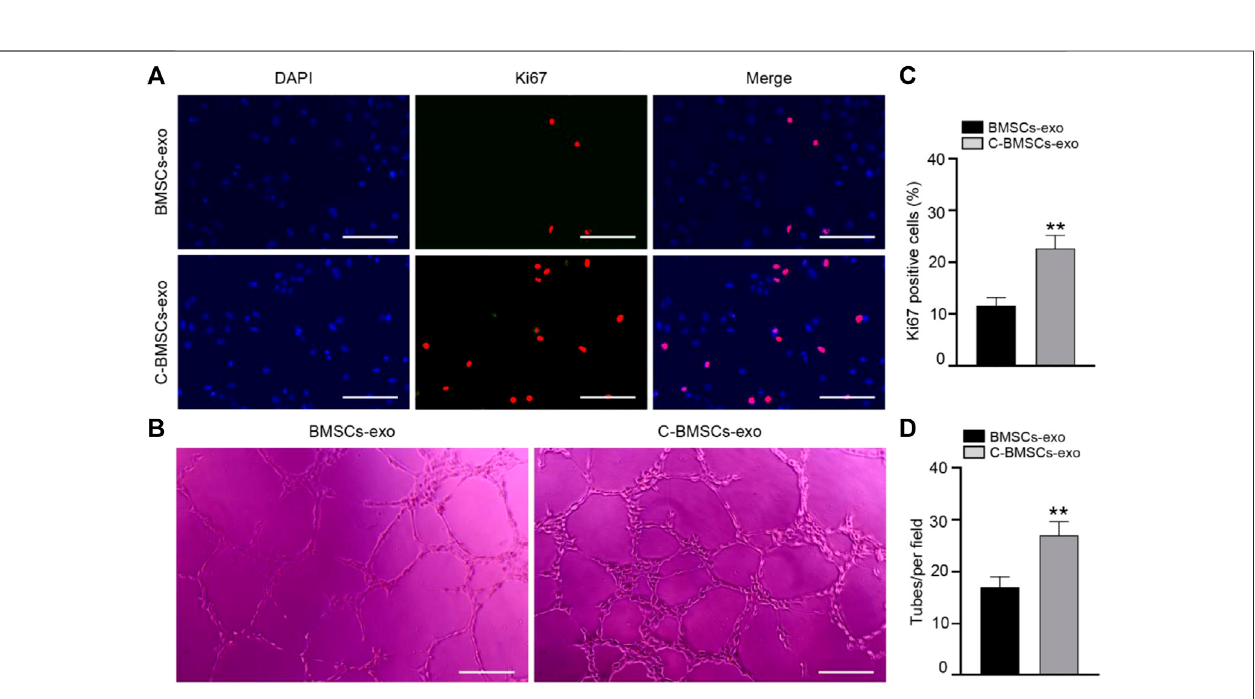
Frontiers in Bioengineering and Biotechnology |